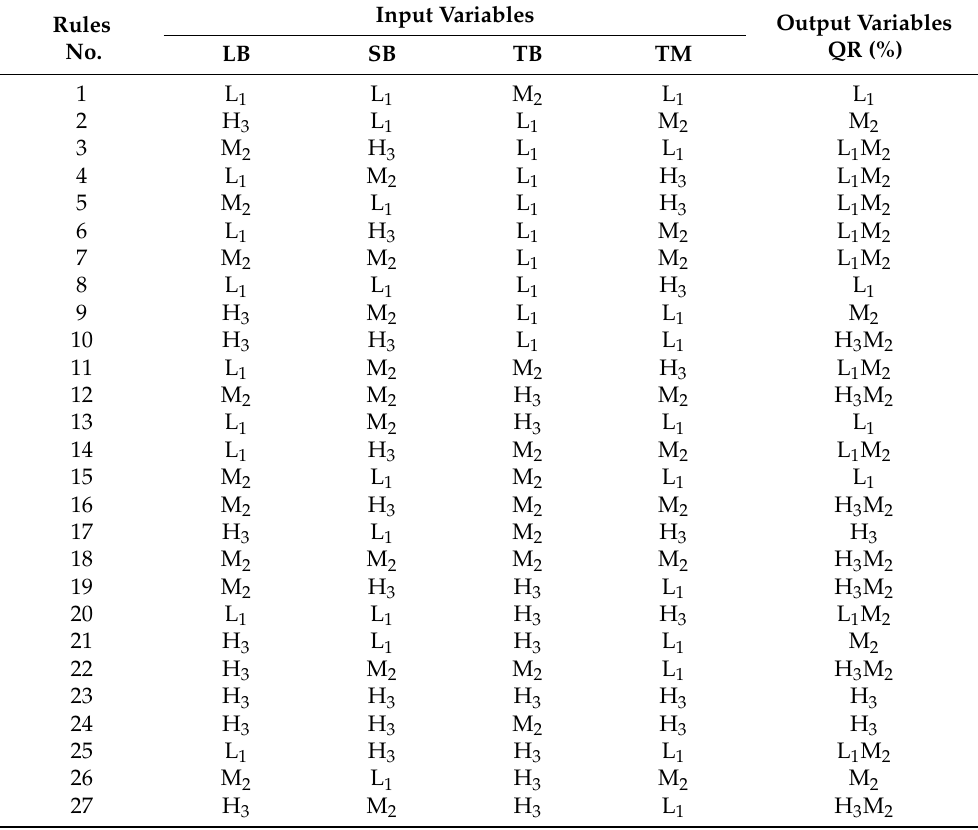
Table 2. Fuzzy Inference rules for input and output